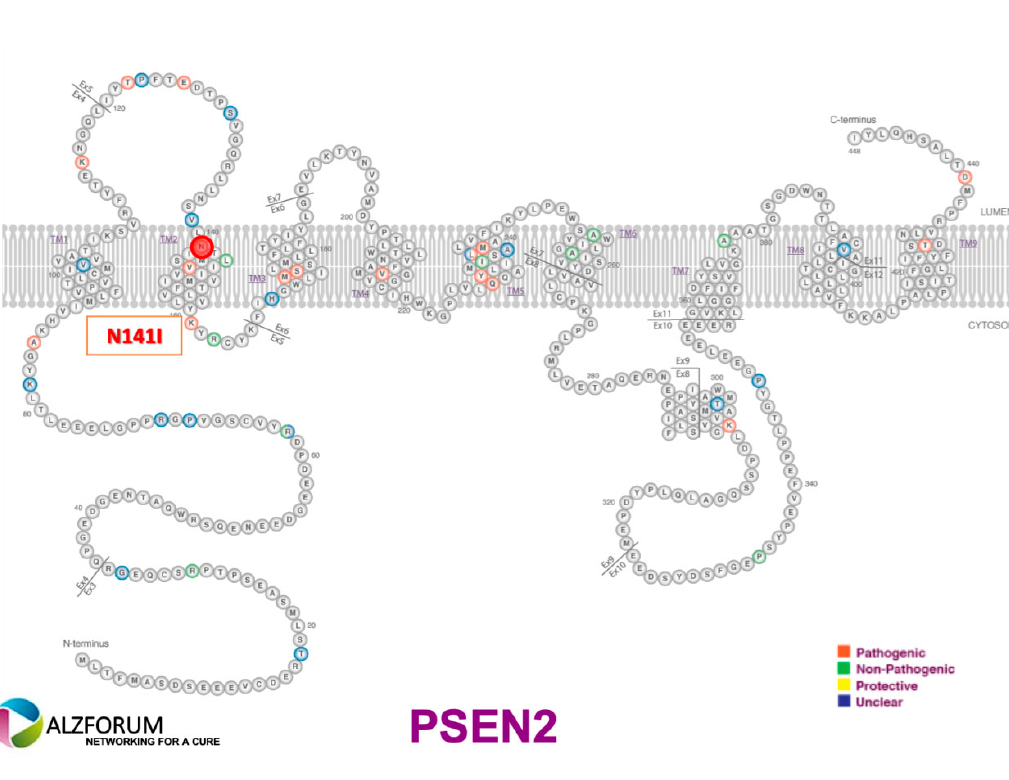
PSEN2: Presenilin 2. Figure 2. Latin American Presenilin 2